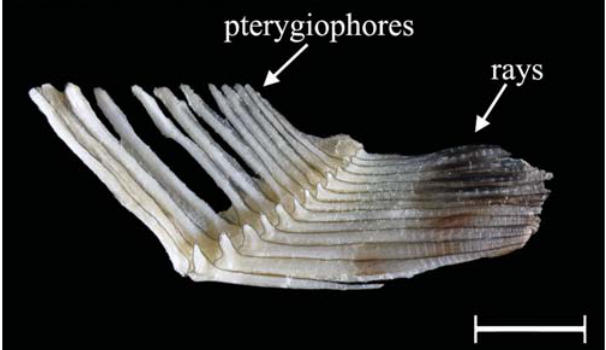
Fig. 8. Anal fin in lateral view of a nuptial male of Liosomadoras oncinus , MZUSP 105828, 99 mm SL. Scale bar = 5